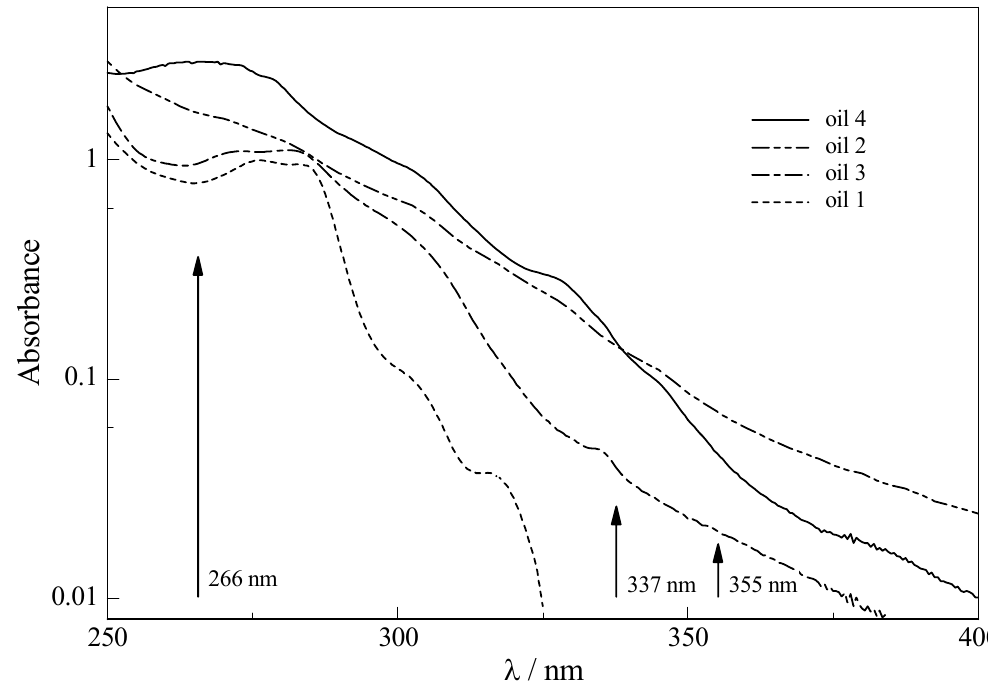
Figure 1. Absorption spectra (semi-logarithmic representation) of the hydraulic oils in cyclohexane solution (5 g/L, 1 cm optical path length). Arrows denote the laser excitation wavelengths employed.